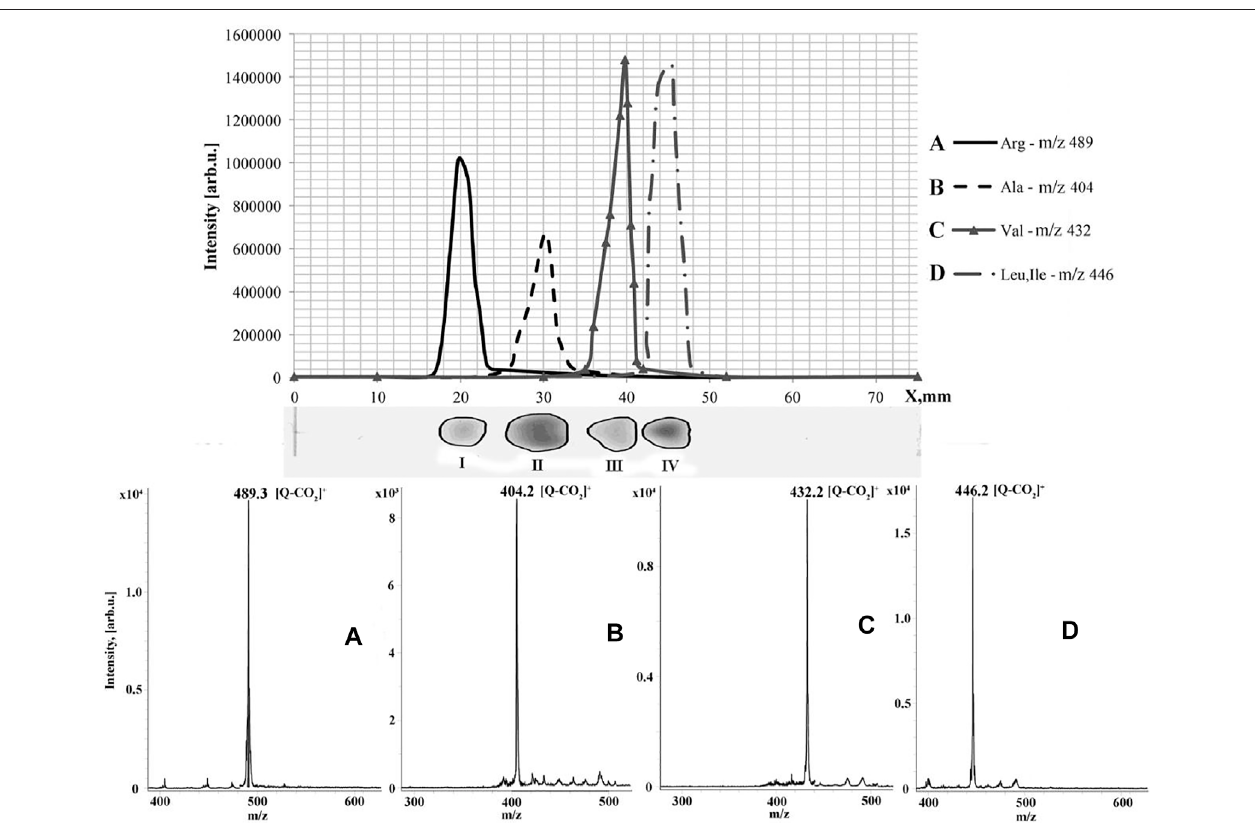
FIGURE 5 | Graphic and real thin-layer chromatograms (top two images) of dietary supplement and recorded MALDI mass spectra of TDPMH derivatives of the detected amino acids (bottom images). Figure reprinted with permission from Esparza et al. (2020). Copyright (2020) Elsevier B. V.